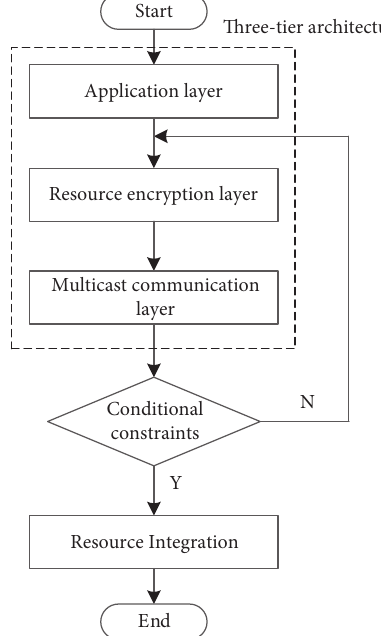
Figure 4: Work flowchart of the remote education resource in- tegration